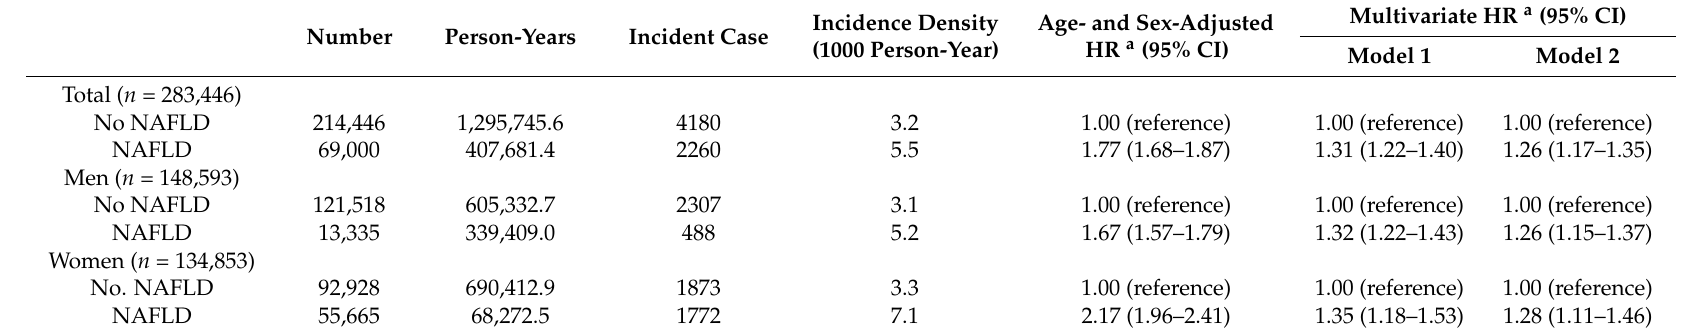
Table 2. The associations between nonalcoholic fatty liver disease (NAFLD) and the development of